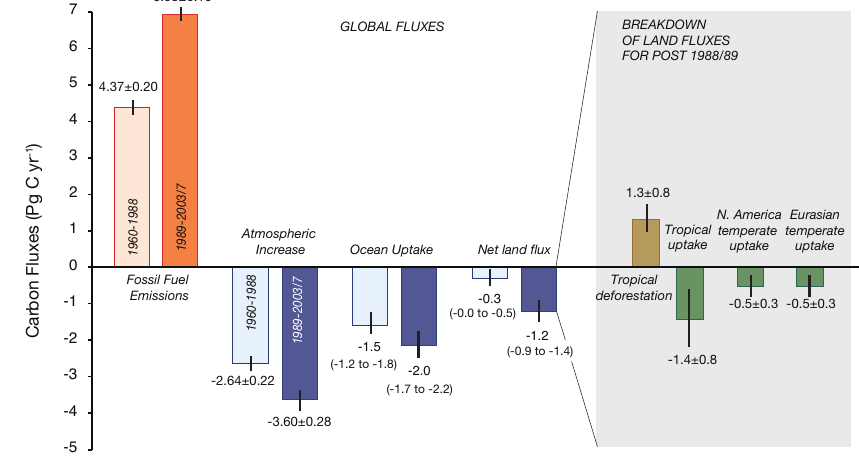
Fig. 3. Global flux estimates for 1960 to 1988 and 1989 to 2003/7 obtained by averaging the fluxes shown in Fig. 1 and Table 2. The shaded region on the right summarizes the post-1988/1989 bottom-up land source and sink components discussed in the